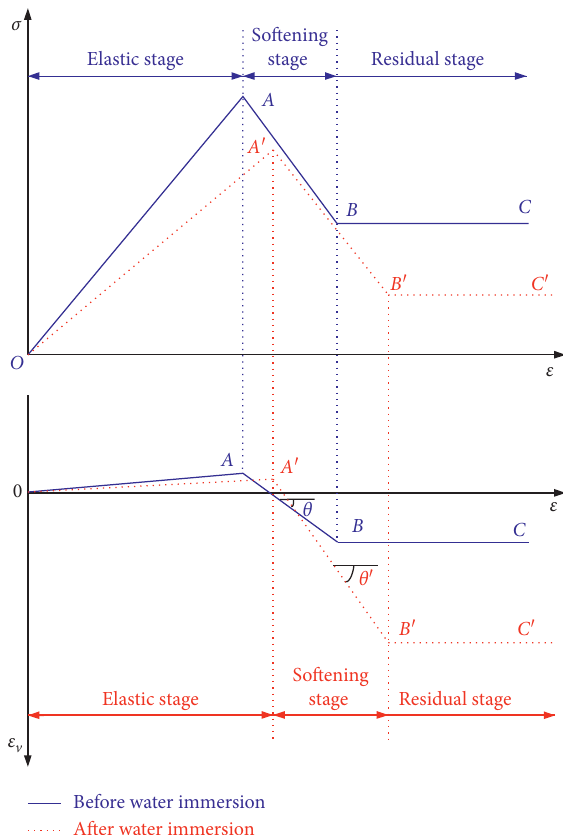
Figure 5: Changes of strength and volumetric strain with strain of weakly cemented soft rock before and after water